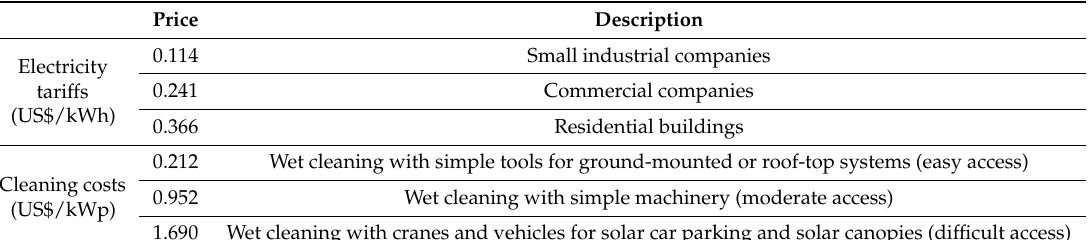
Table 3. Cleaning costs and electricity tariffs for the universities sector in Jordan.